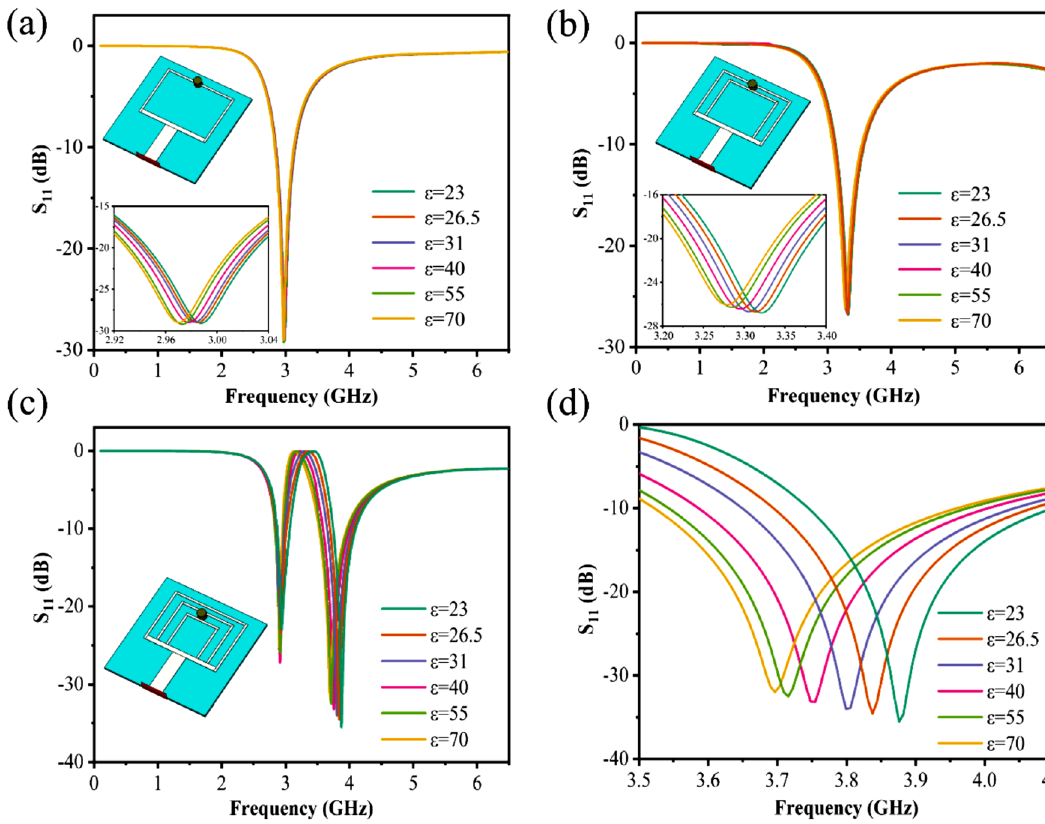
Figure 3. ( a ) Simulation results of a single ring antenna for samples with different dielectric constants (the inset shows the location of the test), ( b ) simulation results of a double ring antenna for samples with different dielectric constants, ( c ) triple ring antennas for different dielectric constants simulation results of the sample, ( d ) enlarged view of the results of the triple ring antenna simulation test at 3.5–4.1